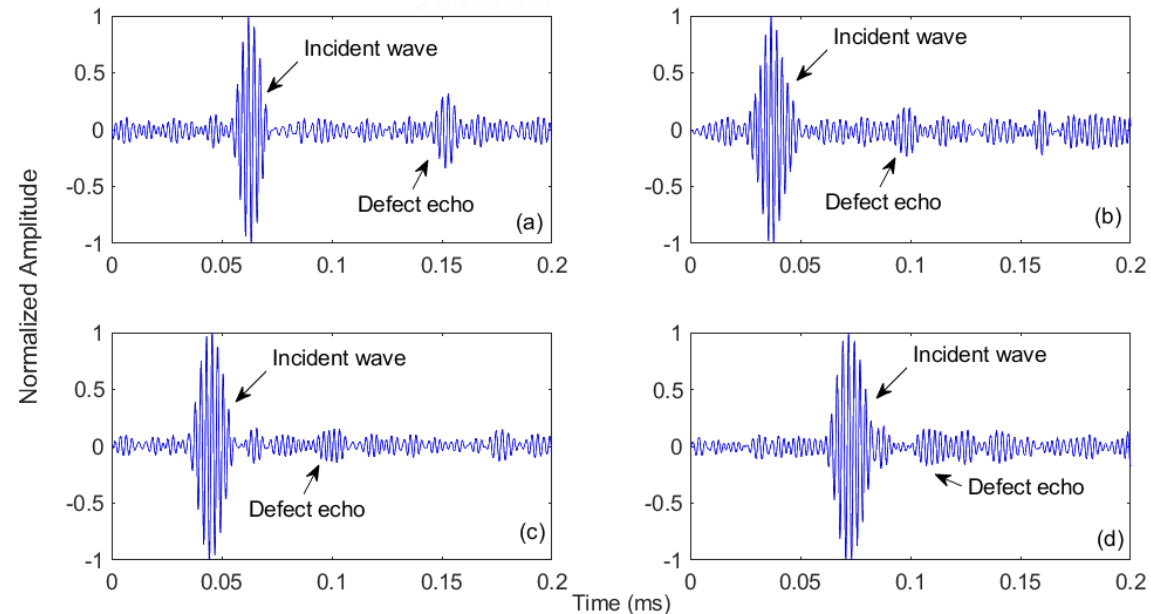
Figure 12. Time plots of the captured signals: time plots of ( a ) specimen B with surface horizontal defect, ( b ) specimen C with surface edge defect, ( c ) specimen D with subsurface horizontal defect and ( d ) specimen E with subsurface vertical defect.